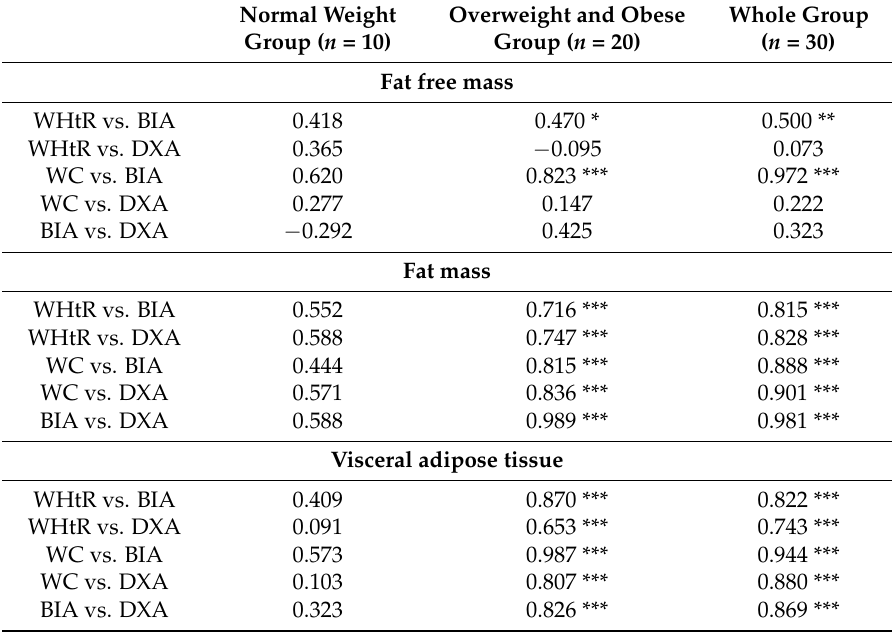
Table 3. Correlation matrix (Spearman’s rho) between BIA, DXA, WC, and WHtR for fat-free mass, fat mass, and visceral adipose tissue (normal weight BMI < 25 kg/m 2 , overweight and obese ≥ 25 kg/m 2 ).